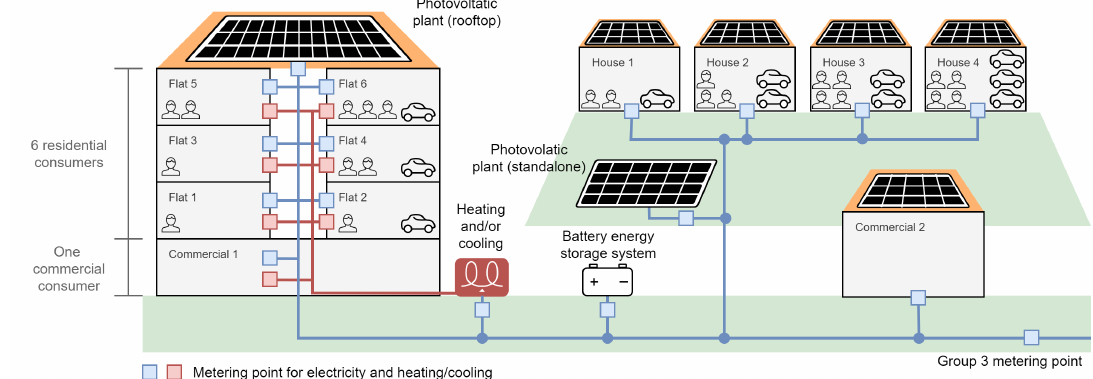
Figure 1. Overview of the ‘typical EU community’ analyzed here. Source: Image adapted from